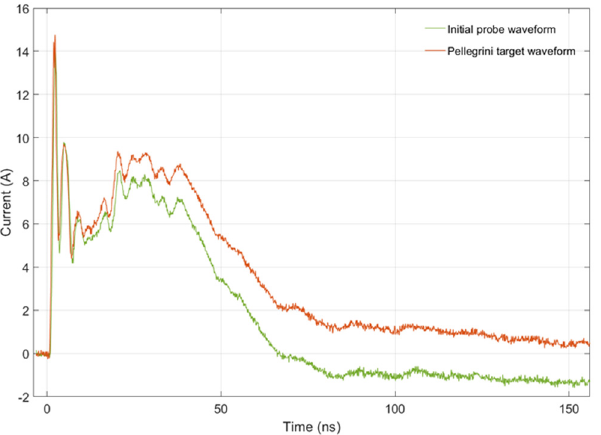
Figure 5. The ESD waveform acquired from the Pellegrini target (orange) and the initial acquired waveform with the current probe without the application of the frequency response compensation method (green).